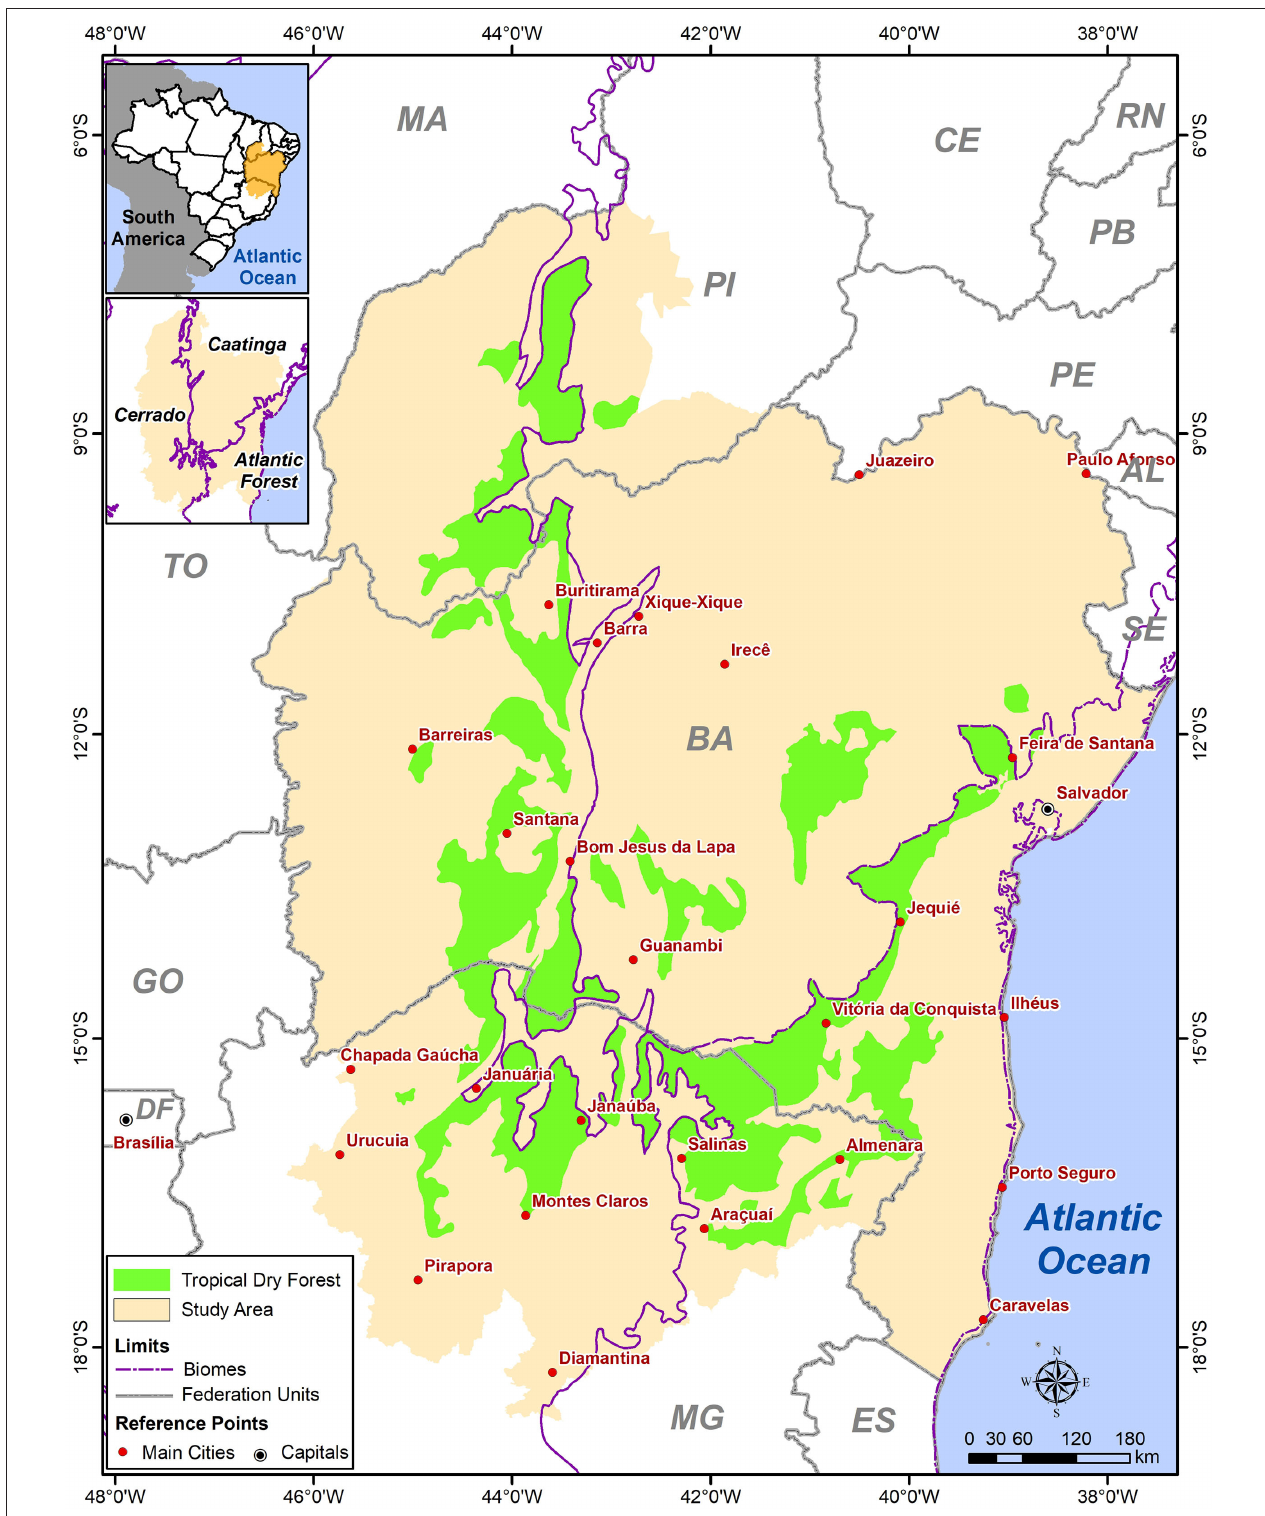
FIGURE 1 | Distribution of tropical dry forests (TDFs) in the northeastern region of Brazil, as legally defined by the Brazilian Institute of Geography and Statistics (IBGE, Federal Decree 6660/2008) to the enforcement of the Atlantic Rain Forest law (see text for further details). Lines represent state (gray) and meso-region (black) limits.